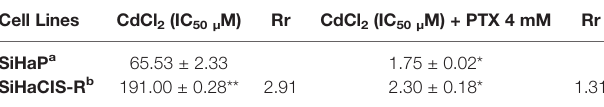
TABLE 4 | Accumulation of Platinum (Pt) in SiHaP and SiHaCIS-R cervical cancer cell lines exposed to Cisplatin and pretreated or not with